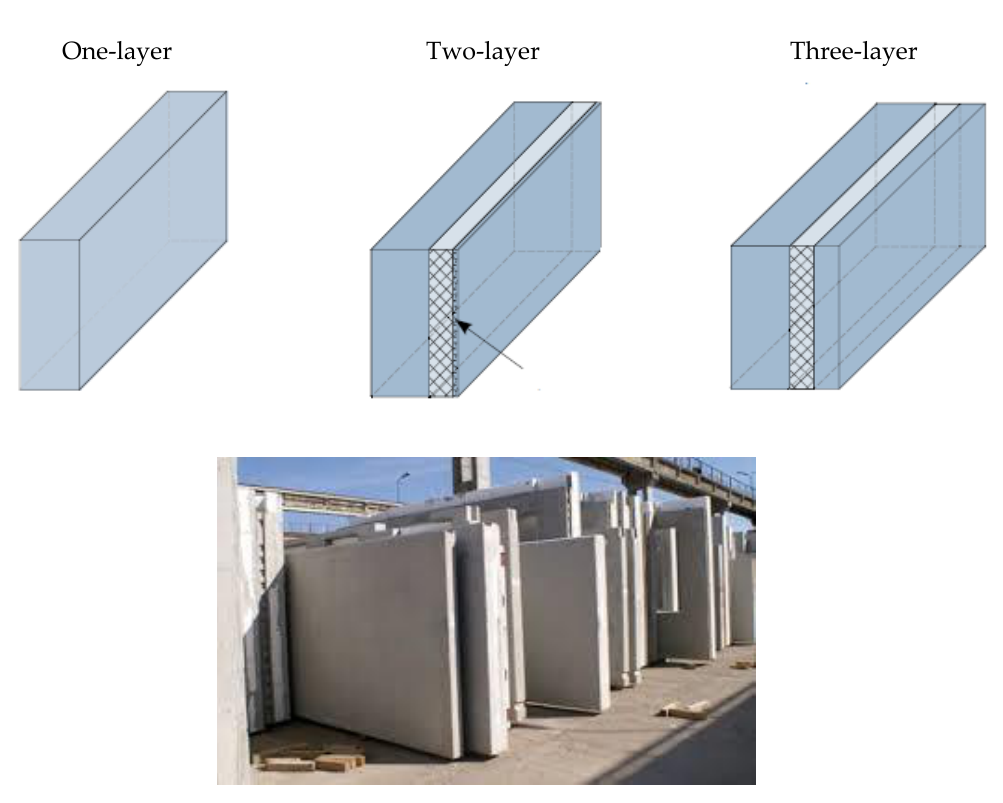
Figure 2. Prefabricated elements storage.